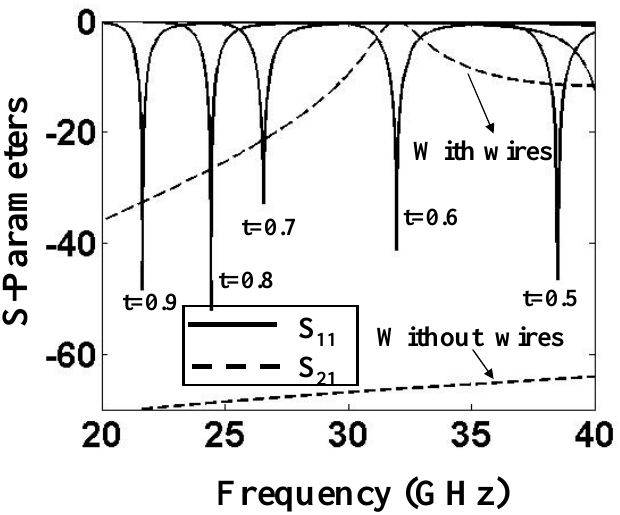
Figure 3. Reflection (solid lines) and transmission (dashed lines) coefficients for different values of the wire length to waveguide height ratio ( t = 2 l /2 a ).